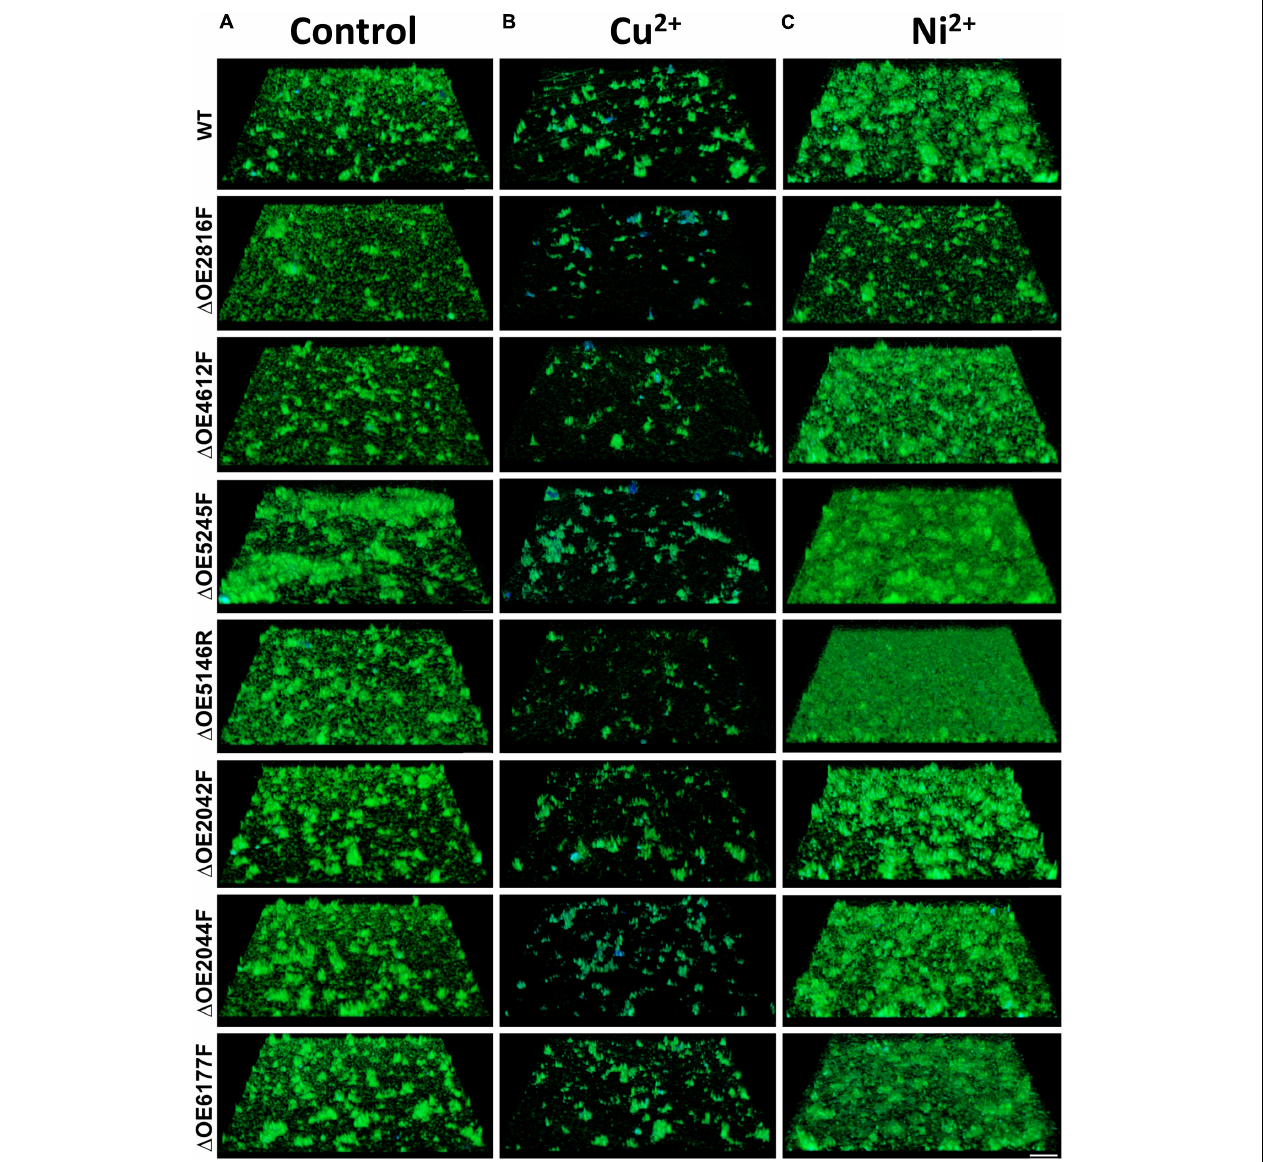
FIGURE 8 | Confocal laser scanning micrographs (CLSM) of biofilms formed by H. salinarum wild type and deletion strains after exposure to metal ions. Biofilms were grown for 14 days in complex medium and were either incubated without treatment (A) or treated with 5 mM Cu 2 + (B) or 40 mM Ni 2 + (C) for 24 h. Genomic DNA was stained using acridine orange (green) and glycoconjugates ( α -mannopyranosyl and α -glucopyranosyl residues) were stained with concanavalin A (ConA) Alexa Fluor R (cid:13) (blue). Scale bar equals 25 µ m. The surface coverage of these biofilms is quantified in Supplementary Figure S1 .